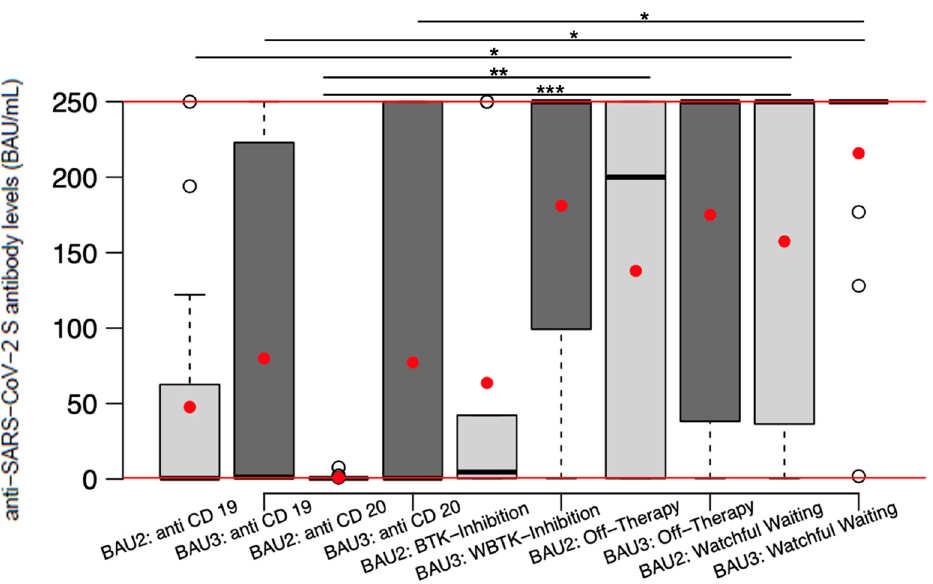
Figure 4. Comparison of the antibody levels induced after the 2nd and 3rd vaccinations by treatment modality. The boxplots indicate the minimum score, lower quartile, median (bold line), mean (red dot), upper quartile and maximum score. The shaded, gray boxes illustrate the interquartile range (middle 50% of data). The whiskers (dashed line) indicate the antibody levels within 1.5 × of the interquartile range from the quartiles (nearest the box edge). The outliers (white circles) are outside 1.5 × of the interquartile range, above or below the upper and lower quartiles. The threshold (lower red line) indicates seroconversion at >0.8 BAU/mL; the upper red line indicates the upper limit of the linear range of the assay (250 BAU/mL). BAU2: antibody values after 2 vaccinations; BAU3: antibody values after 3 vaccinations * p < 0.05, ** p < 0.01 and *** p <